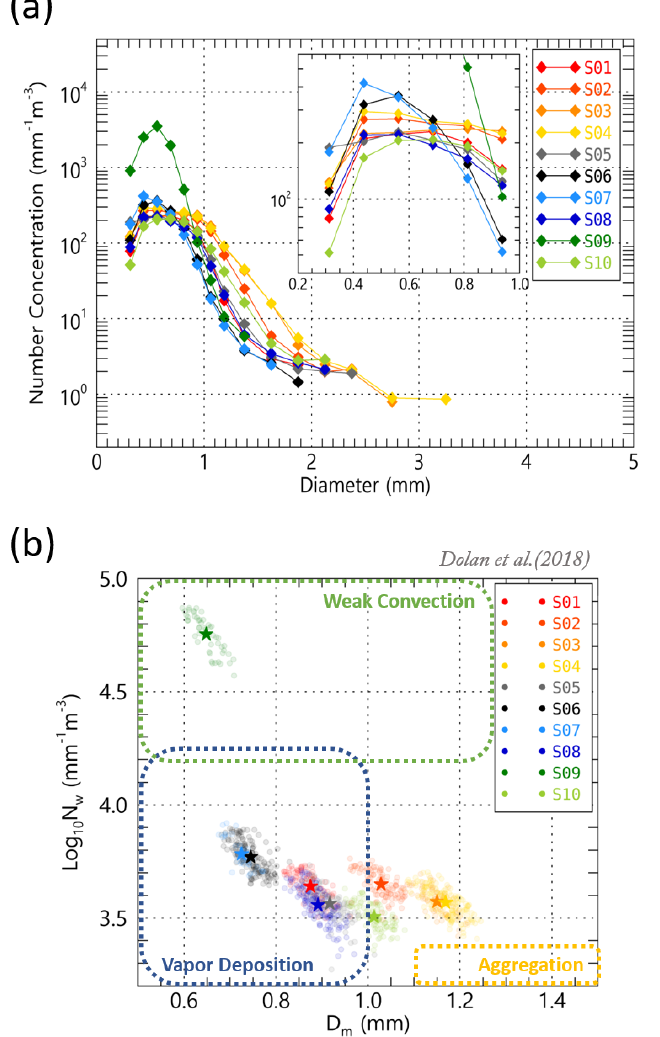
Figure 13. ( a ) The average N(D) versus diameter and ( b ) log 10 N w versus D m distribution for the maximum normalized frequency in Figures 12 and 13. The dot colored boxes are shown in the different microphysical development process areas with log 10 N w versus D m suggested by Dolan et al. [9]. The colored stars mean the average value of log 10 N w and D m at each site.